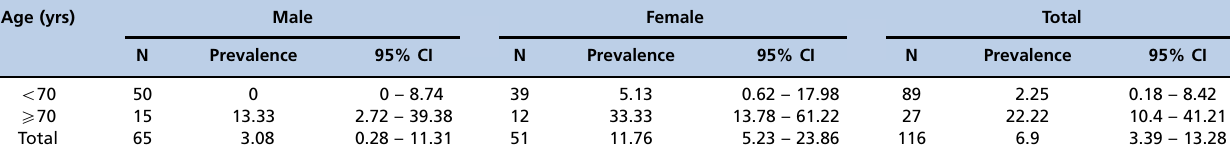
Table 3 - Prevalence of Cholelithiasis (and 95% Confidence Interval) by Sex and Age – Natural Death. Age (yrs) Male